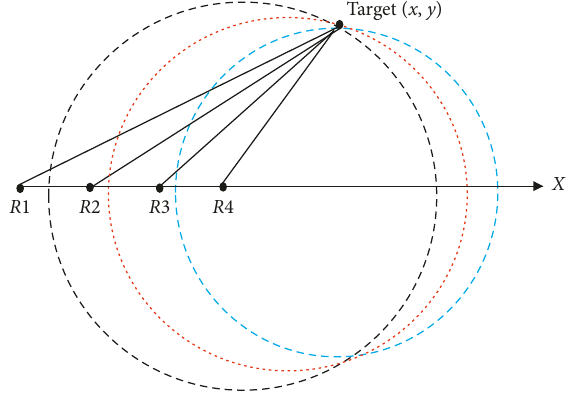
Figure 13: Schematic of multiple receivers with intersecting cir- cular trajectories (target positioning).